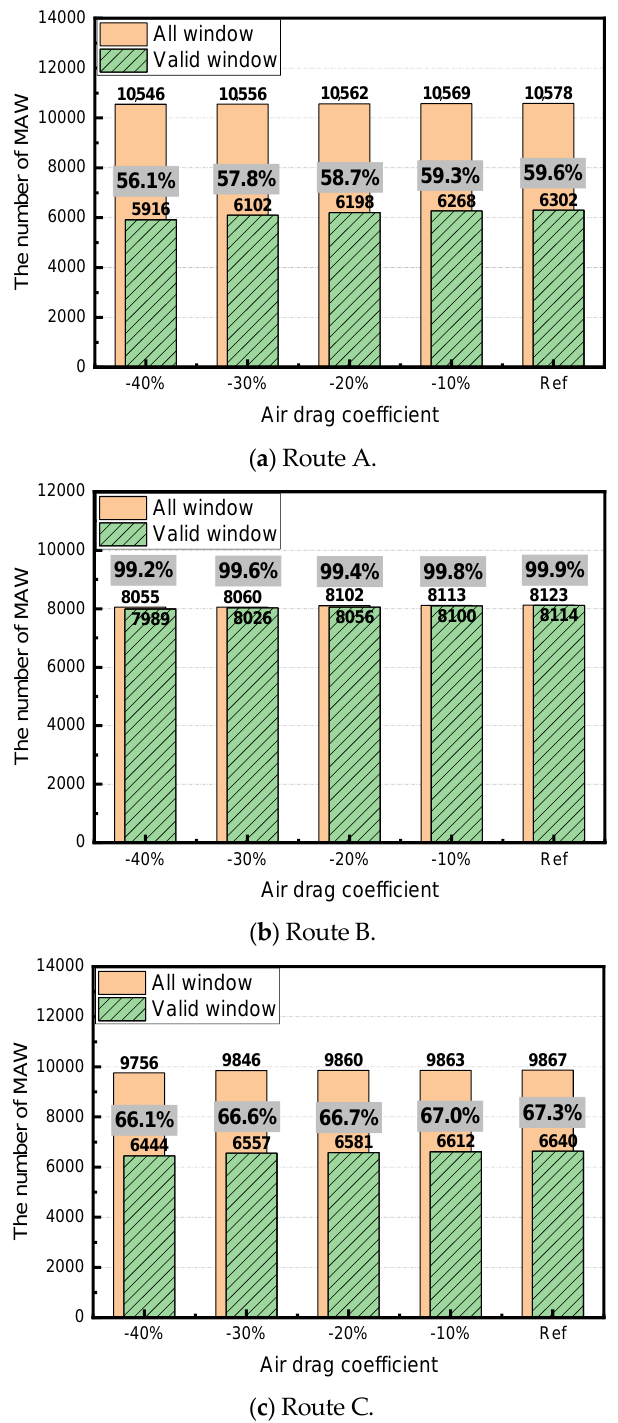
Figure 9. Number of MAWs and the ratio of the valid window with respect to air drag coefficient for each route.